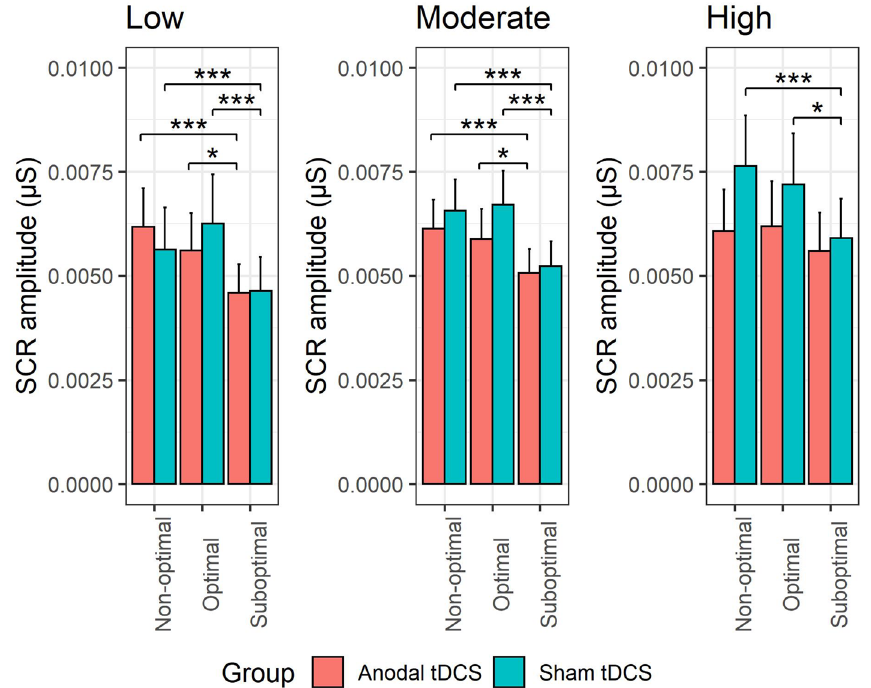
Figure 5. Role of level of self-critical rumination in tDCS effects on SCRs to choice outcomes. Error bars reflect the standard error. * p < 0.05; *** p <